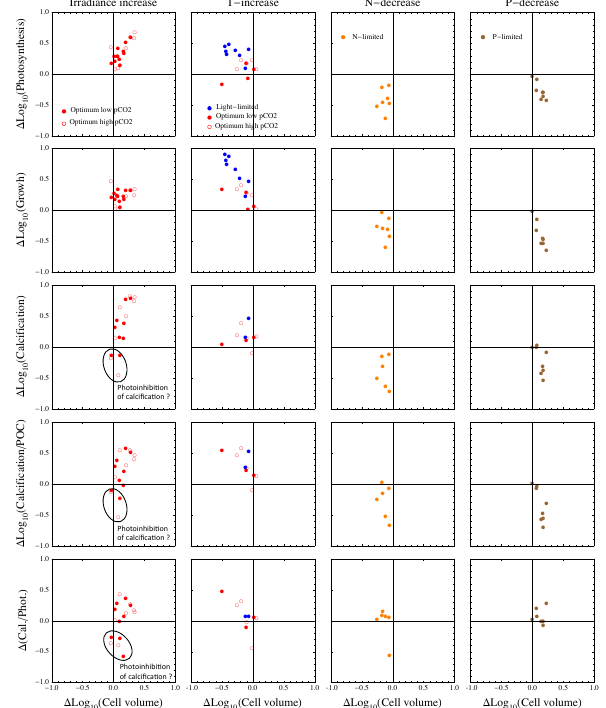
Figure 6. Changes in cell size and metabolic rates of E. huxleyi cells subject to an increase in irradiance (starting from irradiance-limited conditions), an increase in temperature and a decrease in nutrients (starting from nutrient-replete conditions). The symbols represent the different growth conditions defined in Table 2 except for iron, for which there is only one data